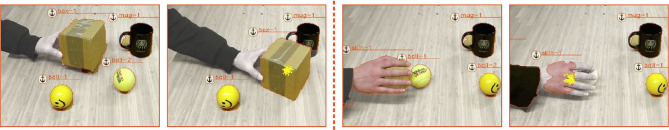
Depicted are two training points in the data set that were used to learn the transition rule of an object to another object. The panels on the left show a ball that is being occluded by a box, and on the right, the same ball that is being grabbed by a hand (or a skin object, as we have only trained our used GoogLeNet model to recognize general human skin objects instead of particular human body parts, cf. section 3.1). The plotted dots on top of the occluding object represent samples drawn from the probability distribution of the occluded object, in other words the object that is labeled in the data set to transition into the occluding counterpart.